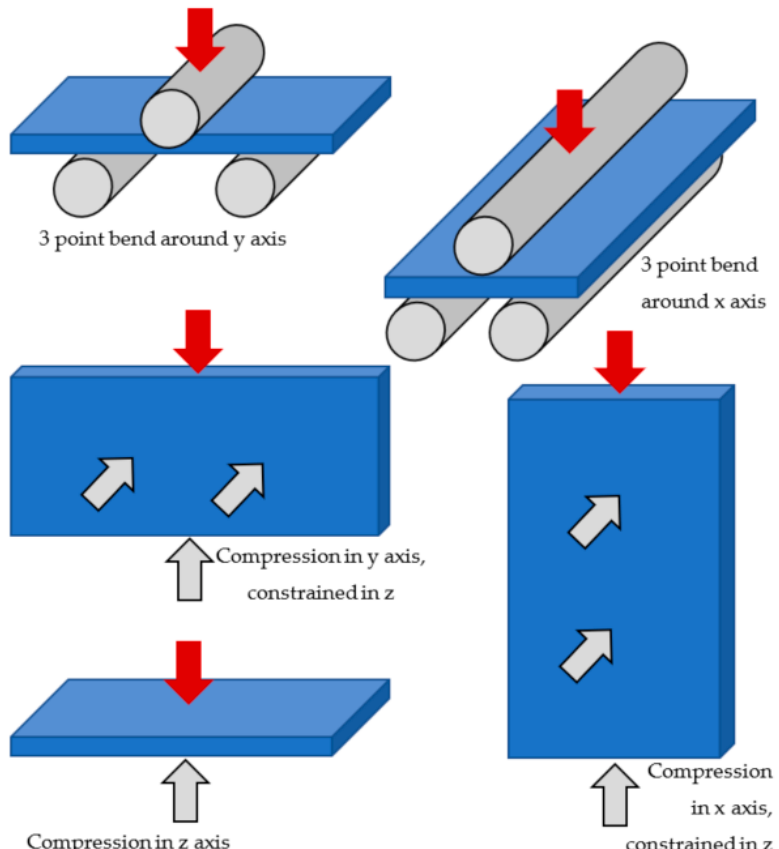
Figure 1. Five load cases used for physical testing and development of the FE macro model. Cells in blue, loading direction in red and fixed supports in